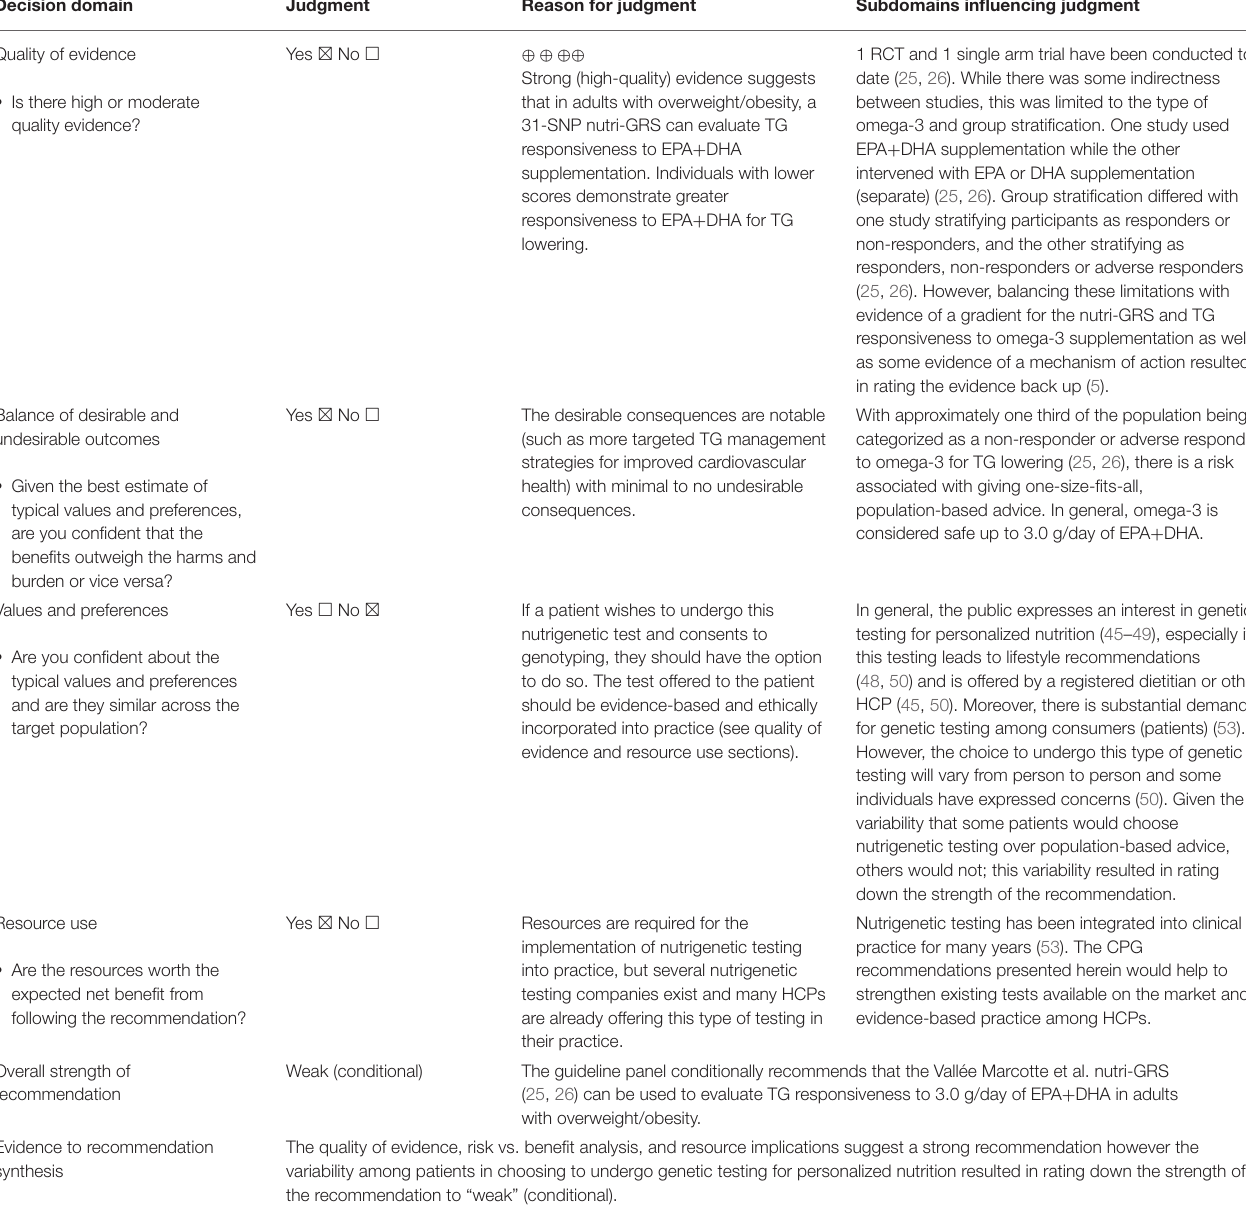
TABLE 1b | Use of the Vallée Marcotte et al. 31-SNP nutri-GRS to evaluate the TG responsiveness to dietary/supplemental EPA + DHA in males and females with